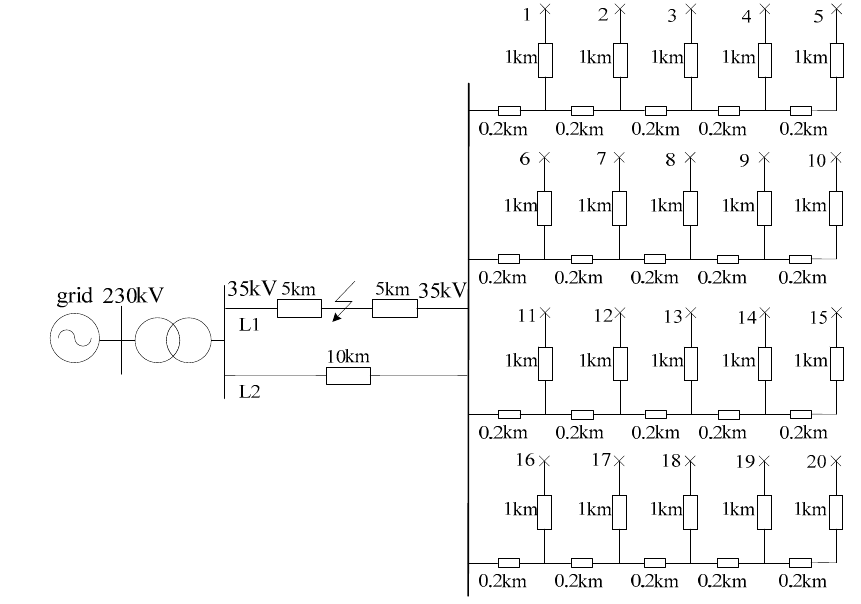
Figure 5. 20 PMSG wind turbines system. Table 5. Identification intervals of